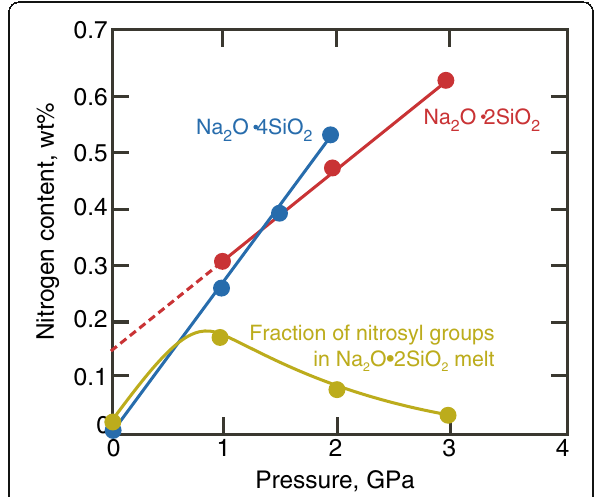
Fig. 16 Solubility of nitrogen under oxidizing conditions in Na 2 O (cid:129) 2SiO 2 and Na 2 O (cid:129) 4SiO 2 melt as a function of pressure. Also shown is the portion of nitrogen that formed nitrosyl groups in Na 2 O (cid:129) 2SiO 2 melts (data from Roskosz et al.